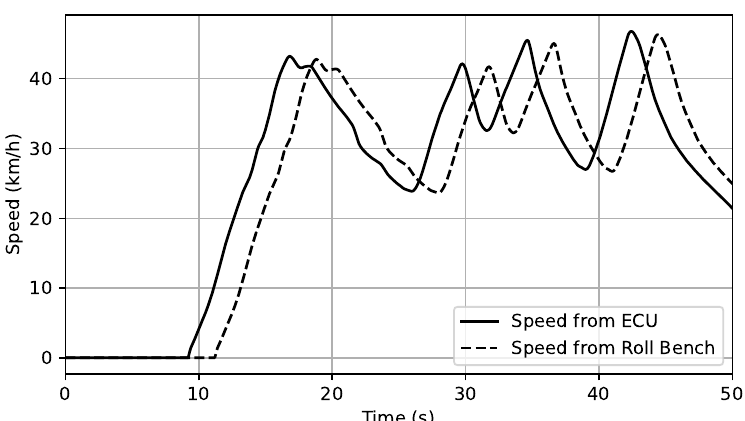
Figure 4. Vehicle speed reference to compensate the delay between the roll bench and the ECU.